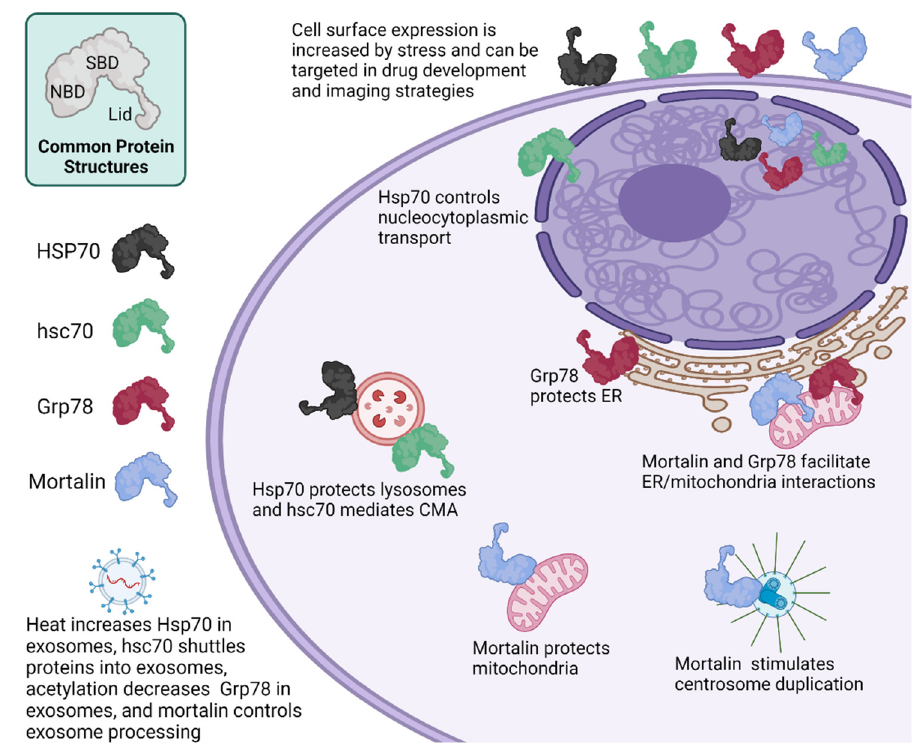
Figure 3. Major areas of cell protection by various HSP70 proteins.